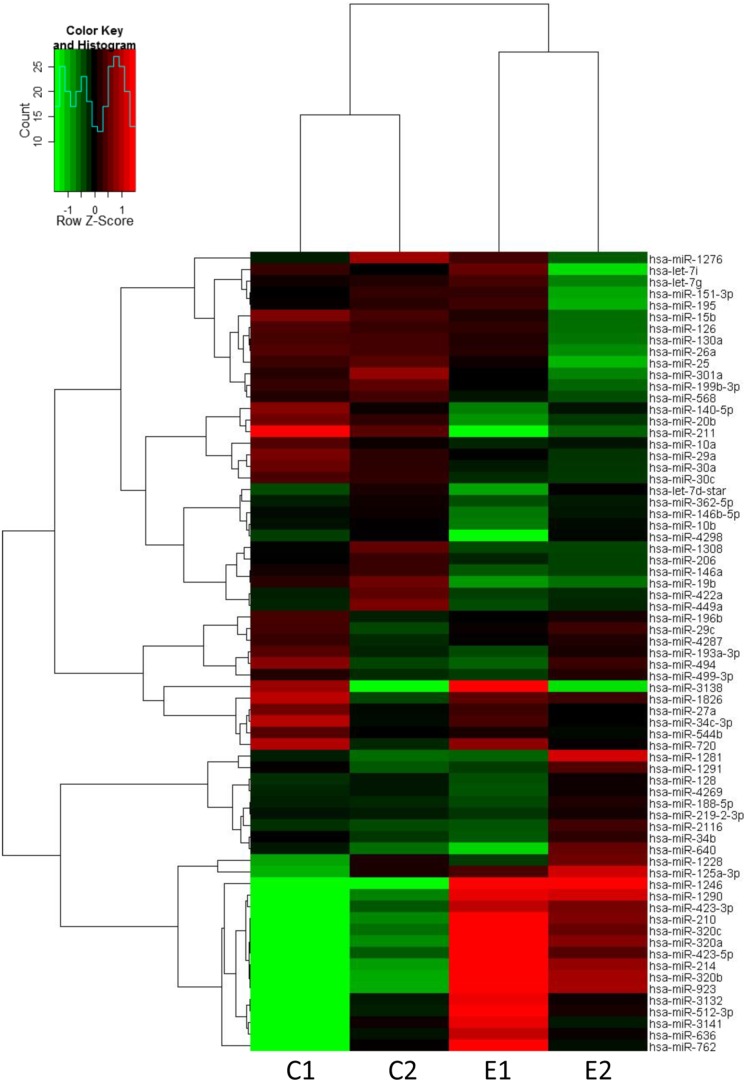
Heatmap and hierarchical clustering of miRNA.The heatmap represents the results of the two-way hierarchical clustering of miRNA and samples. Each row represents a miRNA, and each column represents a sample. C_1 and C_2 represent the non-infected cells at 6 and 12 hpi, respectively, and E_1 and E_2 represent the infected cells at 6 and 12 hpi, respectively. Up-regulated miRNAs are shown in red, and down-regulated miRNAs are shown in green.